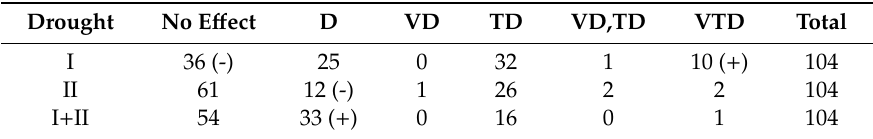
Table 1. Numbers of metabolites in model categories. Sign in brackets: large over ( + ) or under (-) representation of the category (test for independence using permutation, p <